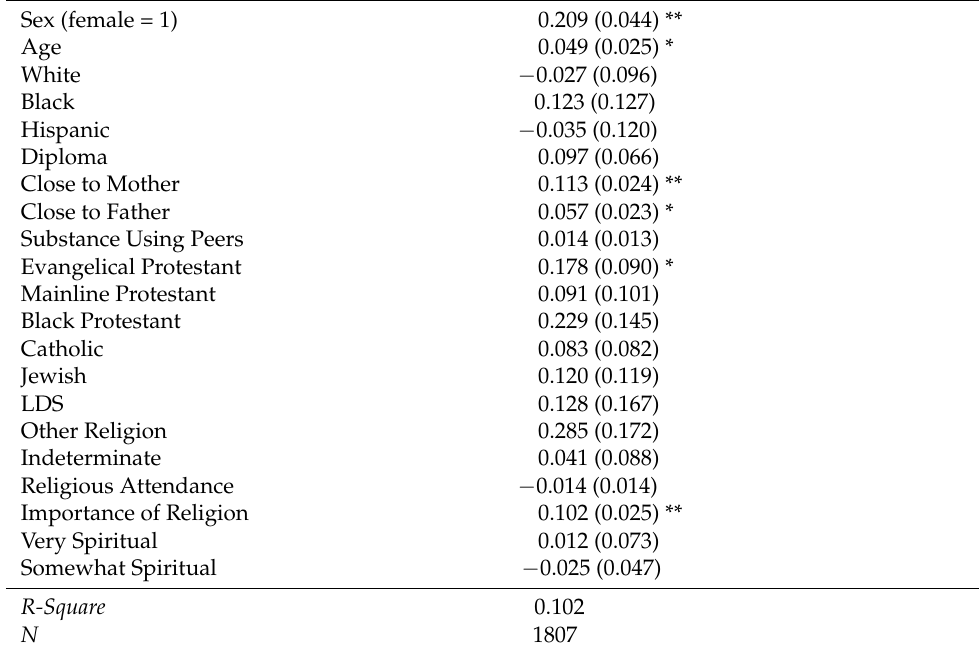
Table 1. OLS Regression of Religiosity and Future Orientation (Standard